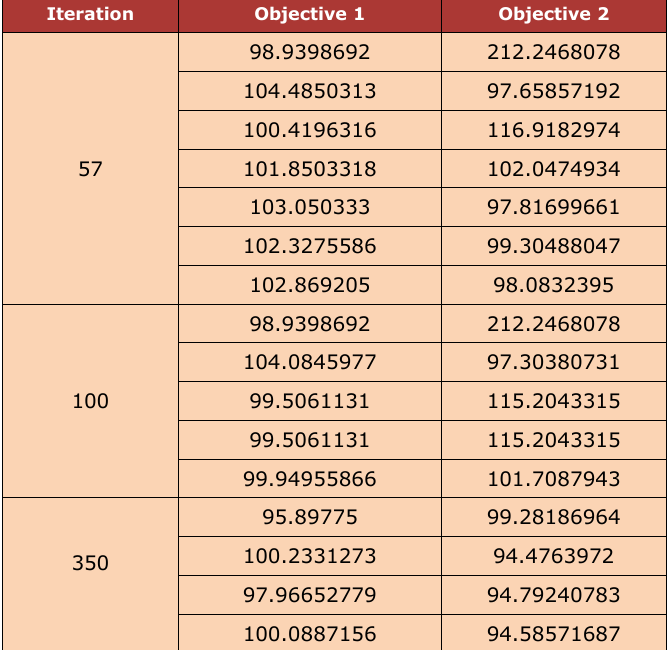
Table 18. Objective values for selected λ